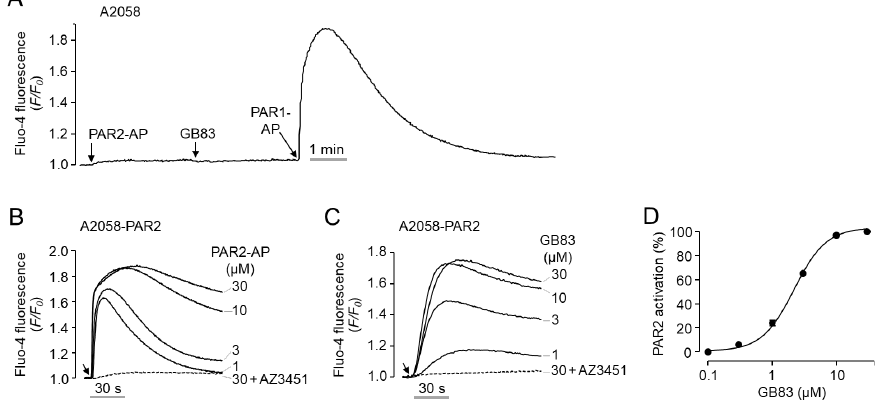
Figure 2. GB83 potently induced a PAR2-mediated increase in intracellular calcium concentration. ( A ) Effect of PAR2-AP (30 µ M), GB83 (30 µ M), and PAR1-AP (30 µ M) on intracellular calcium levels in A2058 cells not expressing PAR2. ( B , C ) Effect of PAR2-AP and GB83 on PAR2-mediated intracellular